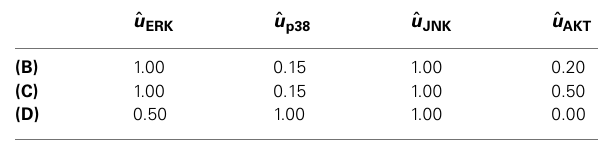
FIGURE 2 | Dynamics of the core network in response to different stimuli. (A) Form of input signals. Solid: sustained input, dashed: transient input. (B–D) System responses for different stimuli. (B) Growth factor strongly stimulating the ERK and JNK inputs, but only weakly the AKT and p38 inputs: (C) growth factor strongly stimulating the ERK and JNK and AKT inputs, but not the p38 input. (D) Stress signal strongly stimulating the p38 and JNK inputs, weakly stimulating the ERK input and not stimulating the AKT